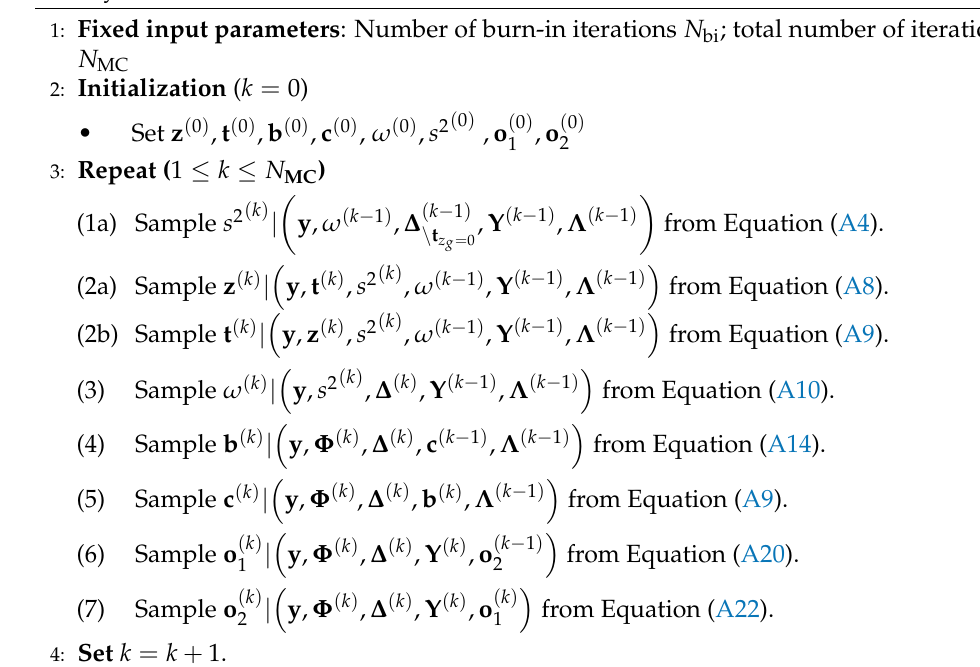
Algorithm A1 Split and augmented—partially collapsed Gibbs sampling algorithm for activity estimation in PGET—version